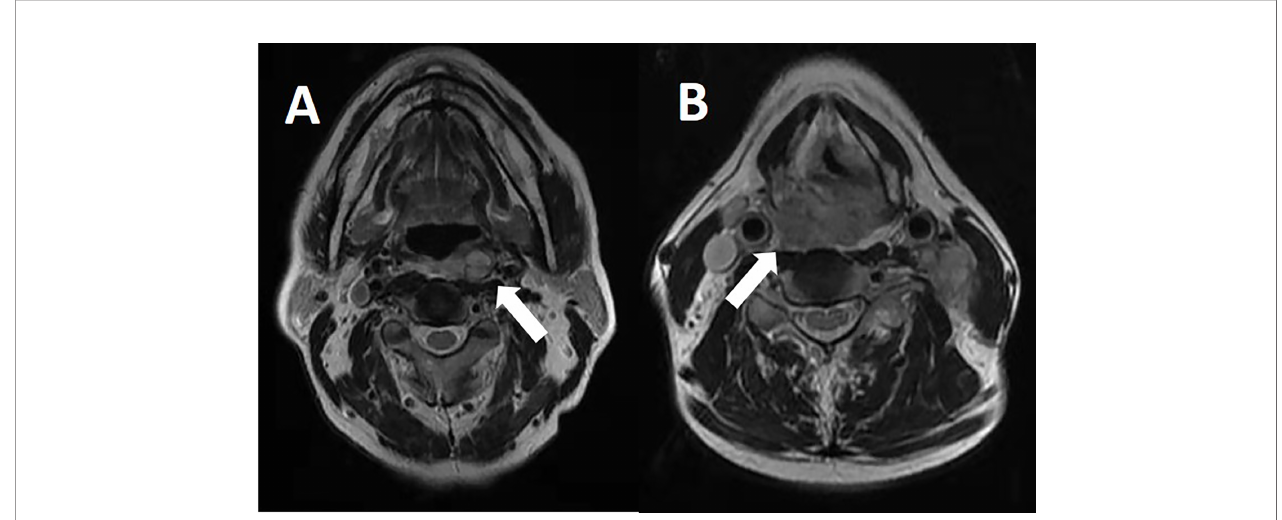
FIGURE 1 | RPLN in MRI images. (A) Left RPLN metastasis in MRI. (B) Right RPLN metastasis in